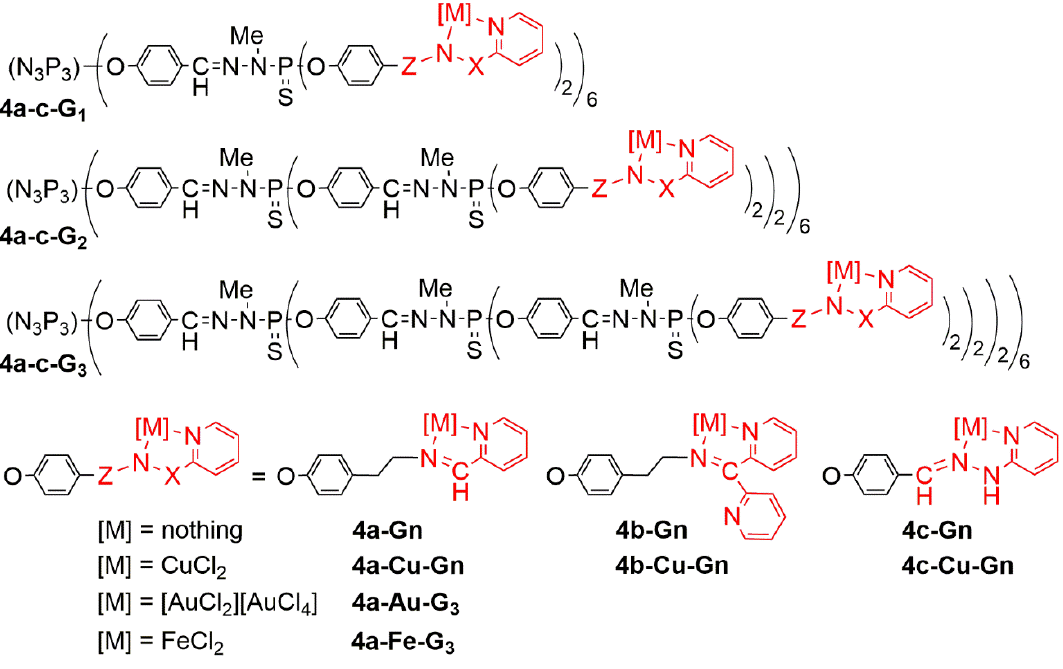
Figure 5. Three generations of dendrimers functionalized by three types of pyridine-imine ligands, and their copper, gold, and iron complexes.